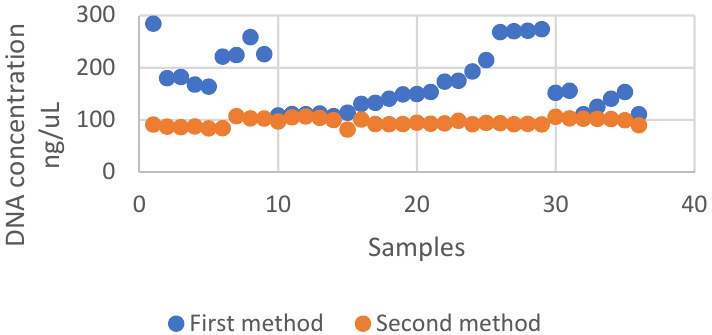
Figure 6. Comparison of the measurement results using the first and second methods of introducing water droplets.